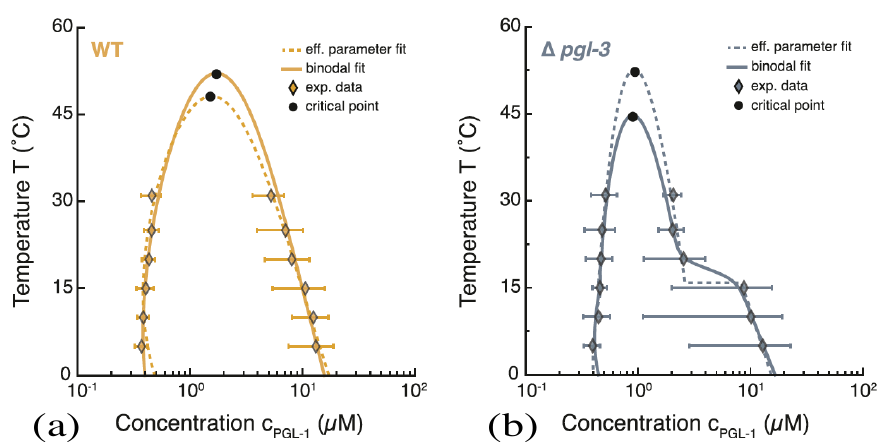
Figure 7. Phase diagram for condensates enriched in the protein PGL − 1 labeled by GFP as observed in P granules of C. elegans cells [32]. The data in ( a ) were obtained for the wild type, those in ( b ) after the deletion of the protein PGL − 3. The experimental data (diamonds) for the binodals are compared with theoretical binodals based on effective parameters for a binary liquid mixture, compare the phase diagram in Figure